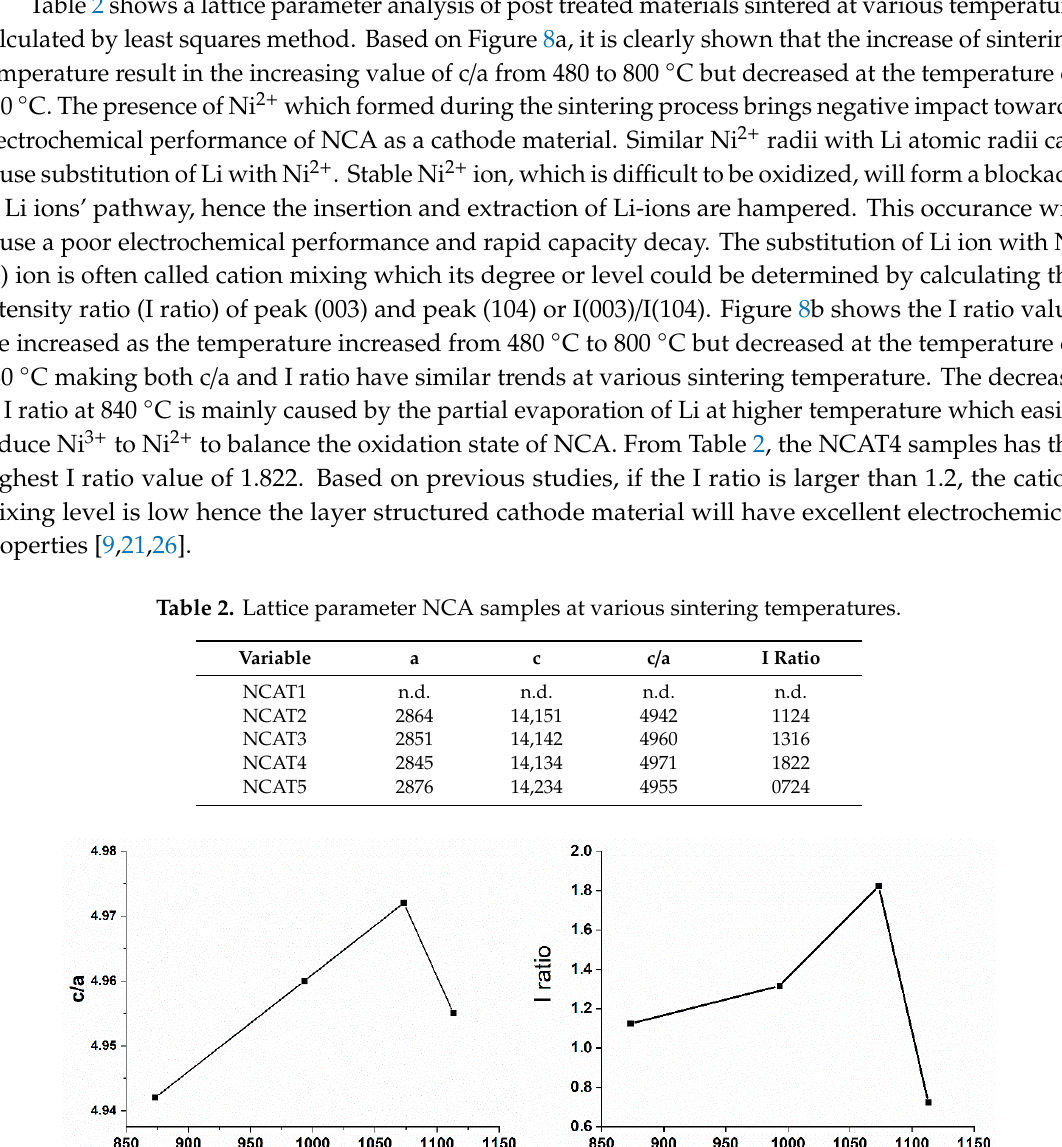
Figure 7. XRD patterns of as prepared NCA cathode material sintered at various temperature for 10 h.